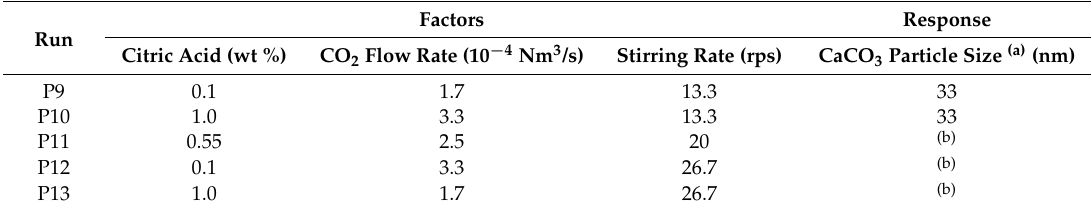
Table 2. Data set for the optimization runs.